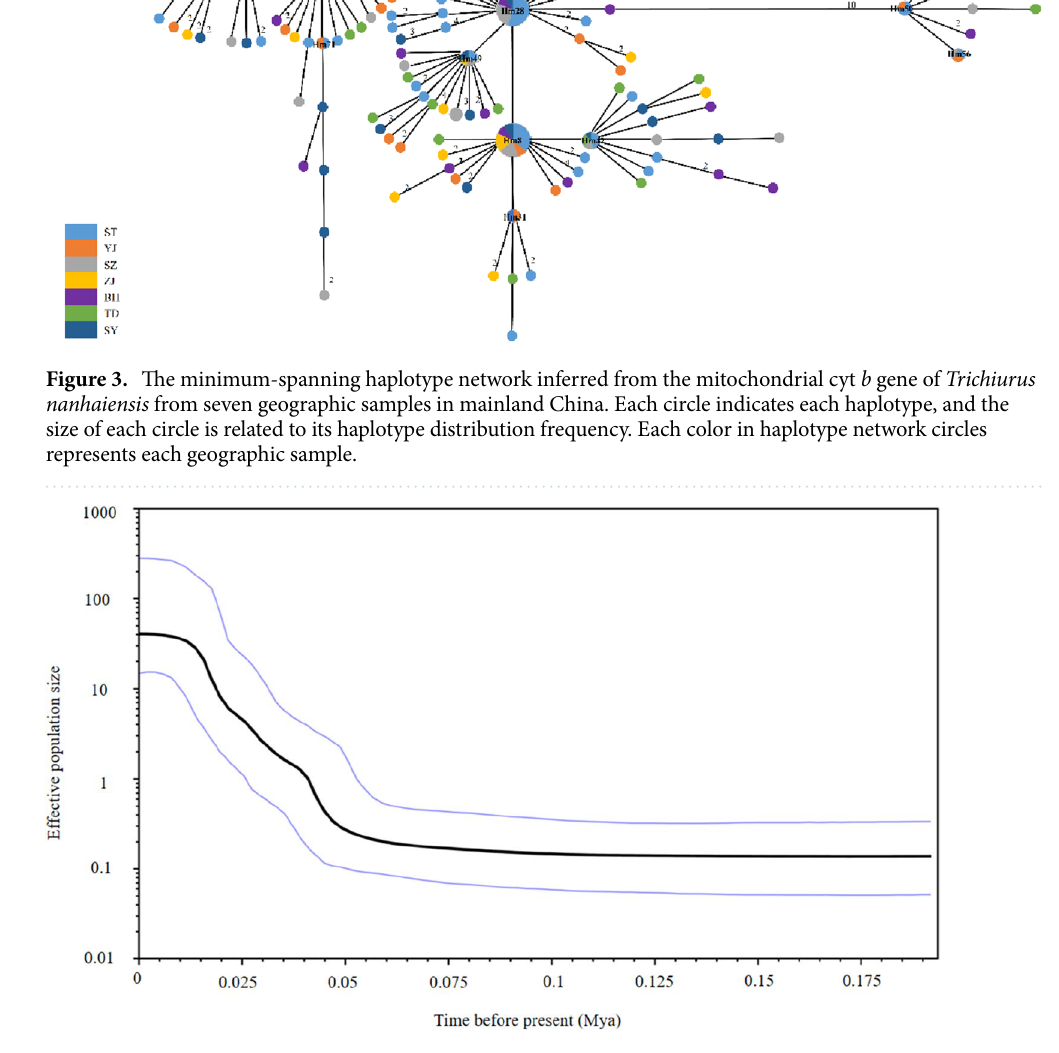
Figure 4. Bayesian skyline plot of the effective population sizes over time for Trichiurus nanhaiensis . The y-axis is the product of effective population size (Ne) and generation length on a log scale, while the x-axis is the time scale before present in units of million years